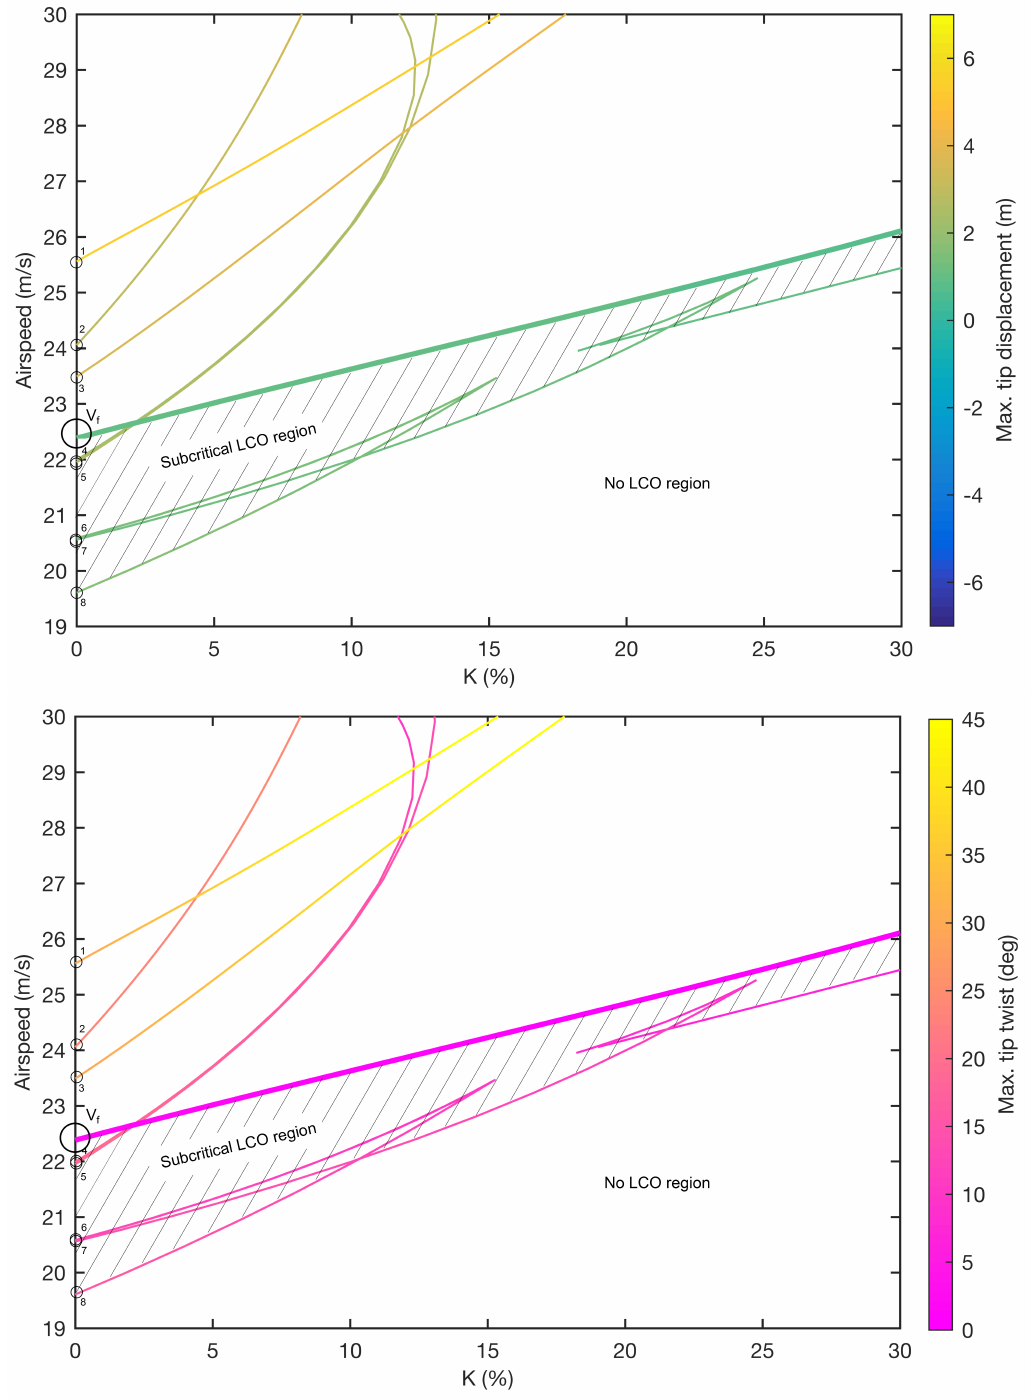
Figure 15. Two-parameter continuation of Hopf points and periodic folds for varying out-of-plane/torsional stiffness coupling and airspeed. The shaded region indicates where subcritical LCOs exist in the